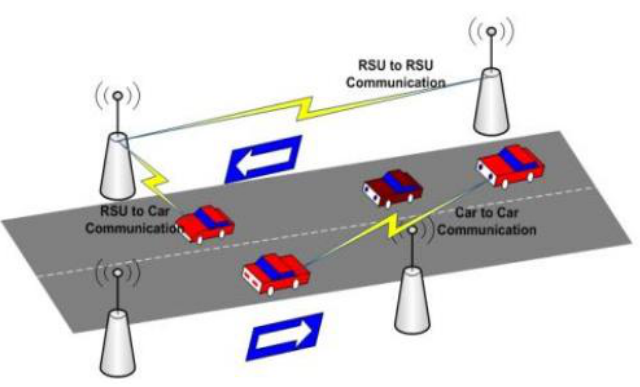
Figure 4. Architecture of MANET, VANET